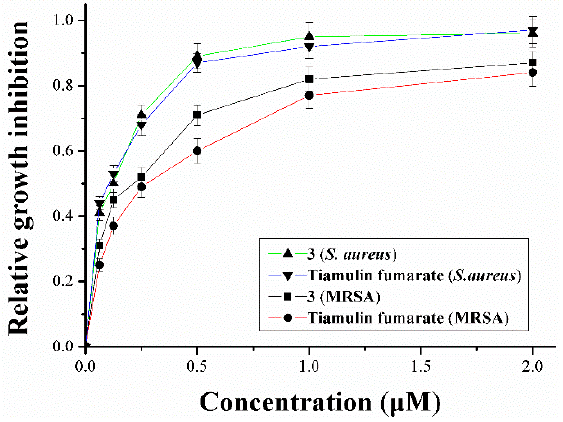
Figure 2. Inhibition of the growth of S. aureus and MRSA by compound 3 and tiamulin fumarate. Data points are the mean from at least three independent experiments carried out in duplicate. The standard deviation is shown as error bars.